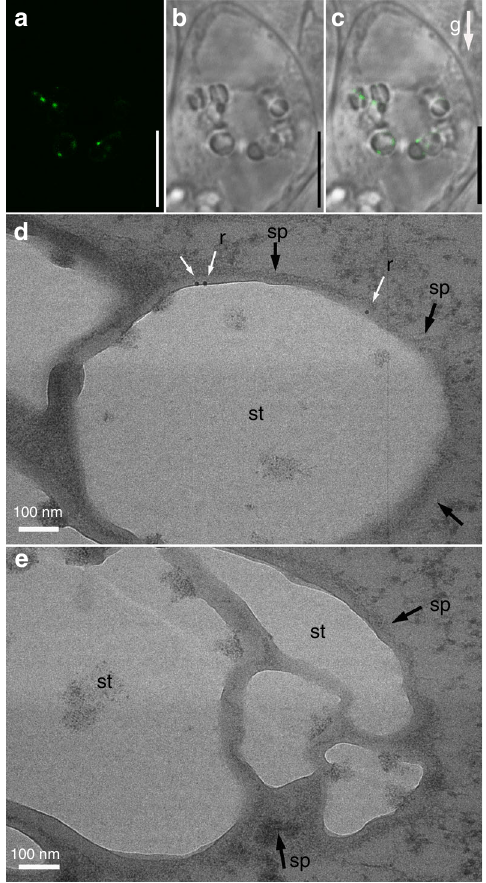
Fig. 3 RMD is localized on the surface of statoliths in columella cells. a – c RMD-GFP co-localizes with statoliths in root columella cells. Bars, 5 μ m. d Immunogold labeling of rice root columella cells using anti-GFP (10-nm gold-conjugated rabbit secondary antibodies, white arrow; statoliths, black arrow) antibodies in RMD-GFP/rmd-1 lines. There are 3 ± 0.333 gold particles detected on the surface of each statolith from the TEM section, 3 biological replicates each with 12 slices analyzed. Bar, 100 nm. sp: envelope of statoliths, st: starch grain, r: RMD-GFP. e Immunogold labeling of rice root columella cells by using anti-GFP antibody (statoliths, black arrow) in WT. Bar, 100 nm. sp: envelope of statoliths, st: starch Fig. 2 Enhanced gravity-sensing in rmd causes hypersensitive root gravitropism. a Speci fi c disruption AFs in primary root tip or elongation zone by 1 µ M LatB treatment. Bars, 10 μ m. b Change in root tip angle of the LatB-treated primary roots at denoted times after gravitropism. Error bars are mean ± SE, n = 3 three independent biological replicates with at least 18 roots analyzed for each assay. c Gus signal was specially observed in columella cells in enhancer trap line A788 . Bar, 200 μ m. d Change in root tip angle of A788 , RMD-AT1 , and RMD-AT2 after 6-h gravistimulation. Error bars mean ± SE, n = 3 three independent biological replicates with at least 20 roots analyzed for each assays. e Transcription analysis of RMD expression level in the primary root tips of A788 , RMD-AT1, and RMD-AT2 . Error bars mean ± SE, n = 3 three independent biological replicates from one representative transgenic line. f The schematic illustration of the experiment. g The representative images of primary roots columella cells after gravistimulation in WT and rmd-1 . Bars, 10 μ m. h , i Box plots of the comparison of the statoliths along the direction of gravity in columella cells between WT and rmd-1 . Every dot represents the average